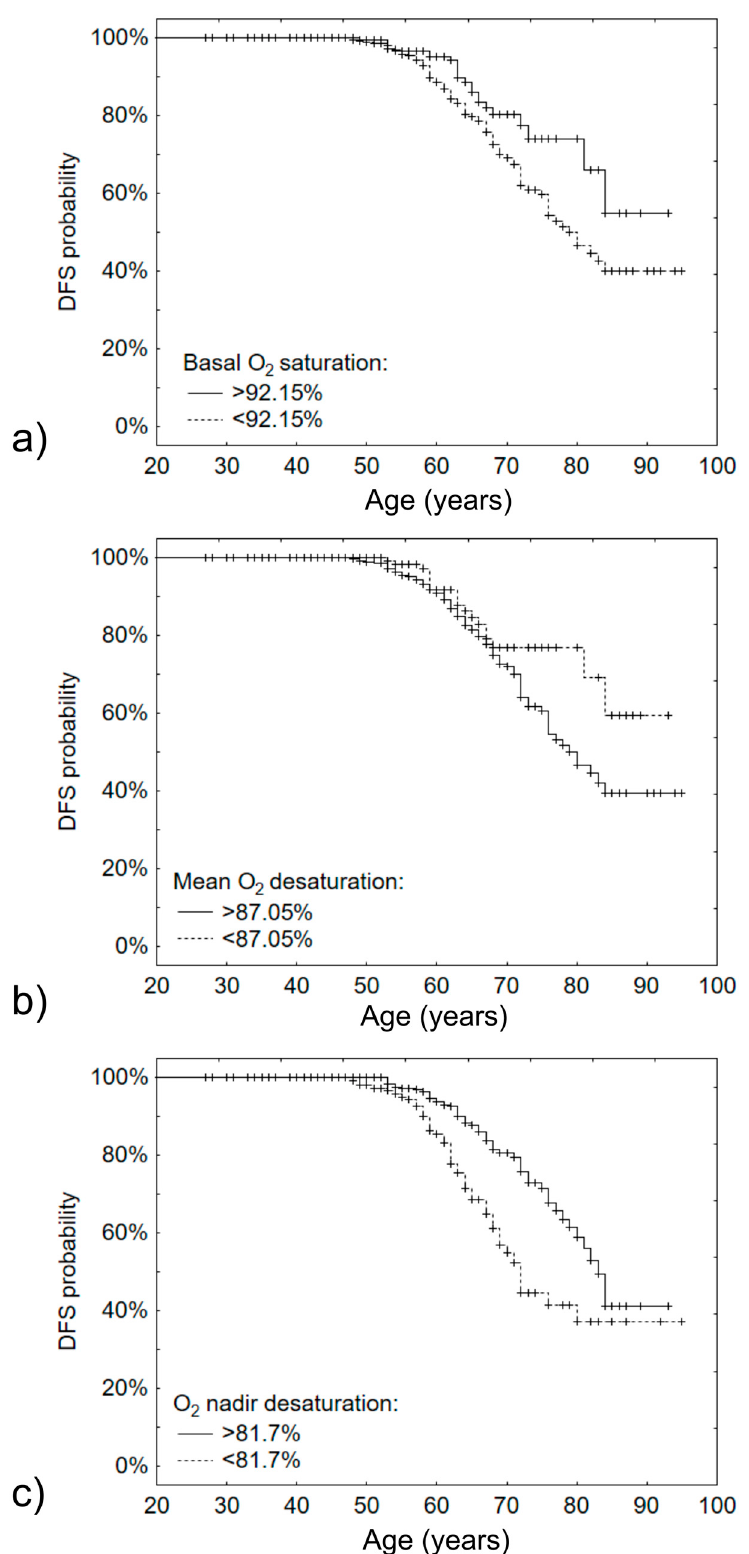
Figure 2. Kaplan–Meier curves for development age of DM2 based on O 2 saturation parameters: ( a )—based on basal O 2 saturation, cut-off point 92.15%; ( b )—based on mean O 2 desaturation, cut-off point 87.05%; ( c )—based on O 2 nadir desaturation, cut-off point 82.7%.